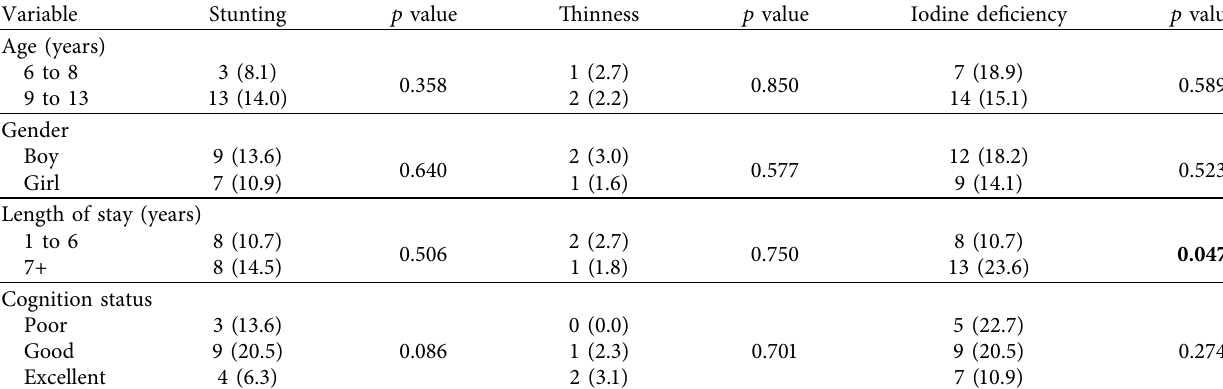
Table 2: Nutritional deficiencies by age, gender, length of stay in orphanage, and cognition status.